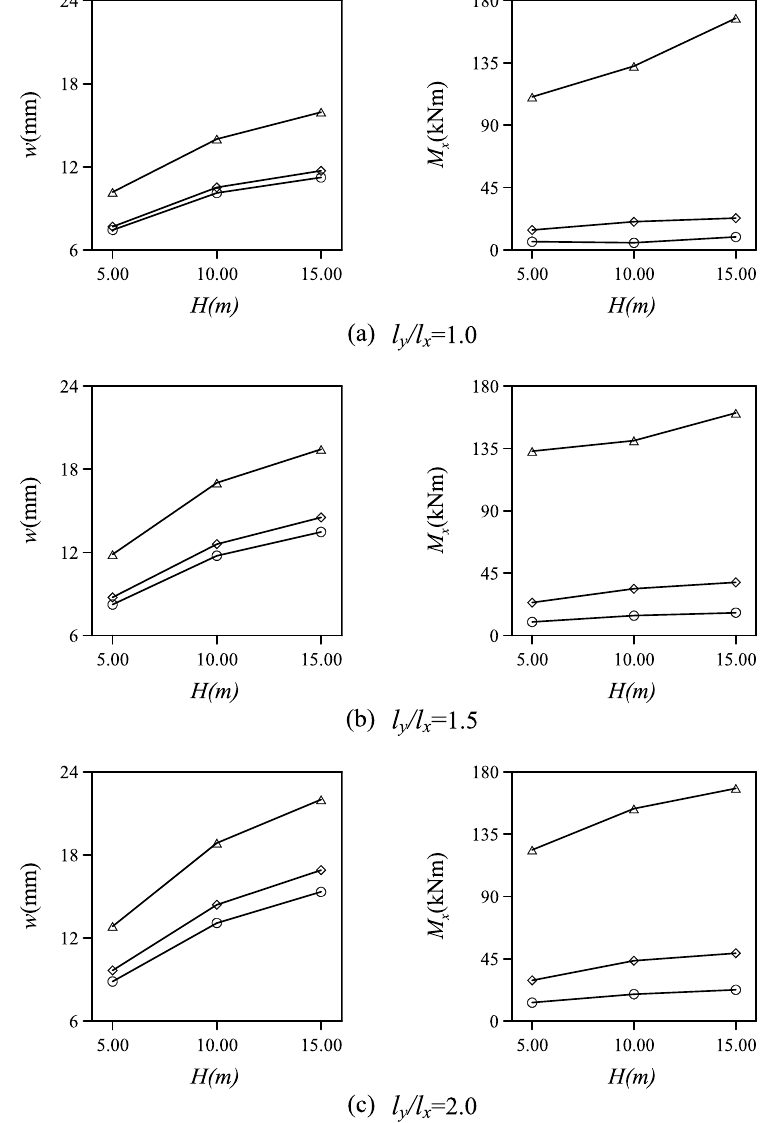
Fig. 8. The variation of the maximum displacement and bending moments with subsoil depth. − Δ − , without beam; −♦− , 1.00 × 1.00 beam; ◦ − − , 1.00 × 1.50